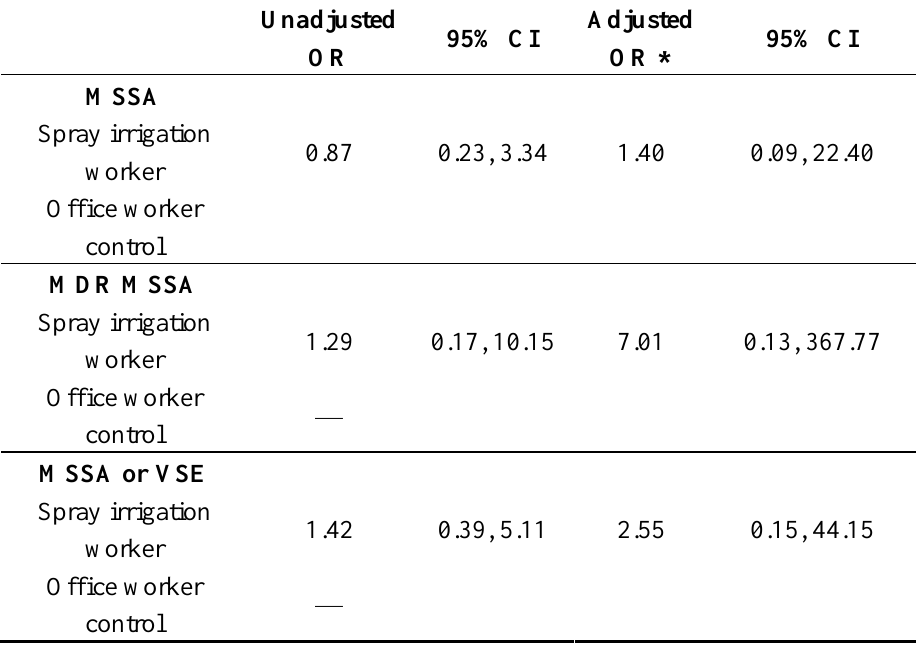
Table 2. Estimated odds ratios of ever being colonized with MSSA, MDR MSSA, or either MSSA or VSE, by occupational